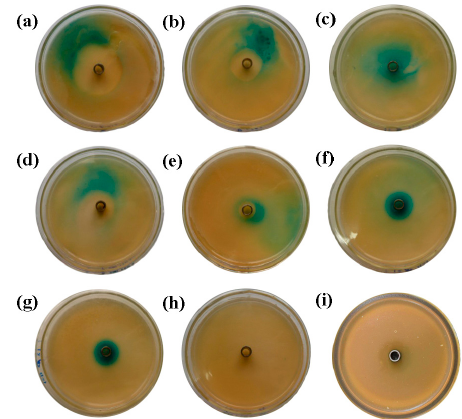
Figure 1. The results of the Oxford cup plate method with bacterial biosensors. ( a – c ) Results using extracts from the Gluconacetobacter sp. strain SX-1 with the biosensor. ( a ) Undiluted N -acyl-homoserine lactone (AHL) extract, ( b ) a 10 fold serial dilution of the AHL extract, and ( c ) a 100 fold serial dilution of the AHL extract. ( d – f ) Results using extracts from G. xylinus CGMCC no. 2955 that paralleled Gluconacetobacter sp. strain SX-1, not repeated here. ( g ) Results using the extracts from Pseudomonas aeruginosa PAK ( P. aeruginosa PAK) with the biosensor, which served as the positive control. ( h ) Bacteria-free water with the biosensor, which served as the negative control. ( i ) Ethanol with the biosensor. ( g ) Results of the Oxford cup method using a 100 fold serial dilution of the AHL extract of P. aeruginosa PAK, which served as the positive control. ( i ) Results of the Oxford cup method using pure ethanol, which served as a control to demonstrate that ethanol can produce zones of bacterial inhibition. There were no significant differences between the Gluconacetobacter strains and P. aeruginosa PAK according to the results of the Oxford cup plate method. This may be caused by a reduction in AHL extract concentration during the preparation process, especially during the extraction and evaporation steps.